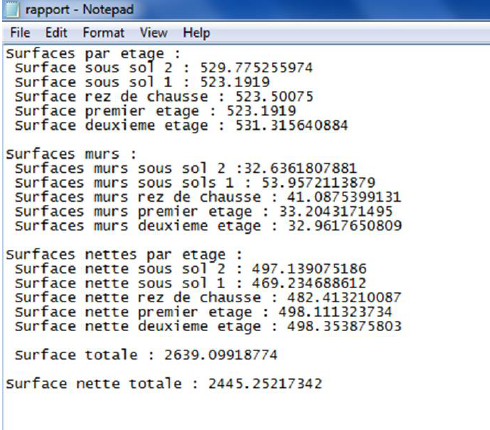
Figure 3 : Door selection based on attribute value-door material Query 2 : Calculate the total floor area of specific building in the university campus?